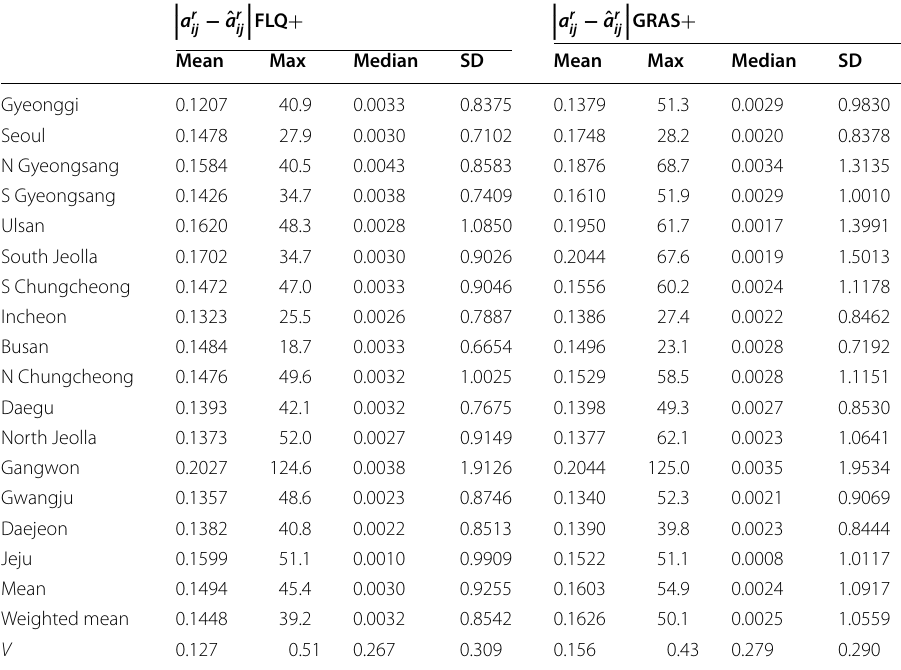
100) between the observed and estimated input × and GRAS + +